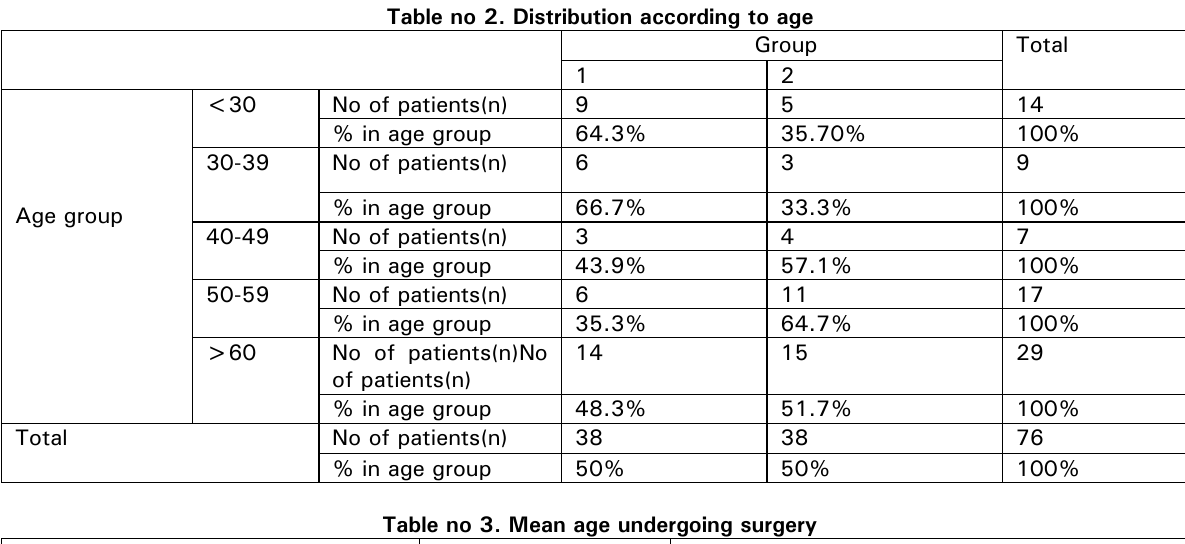
Table no 2. Distribution according to age